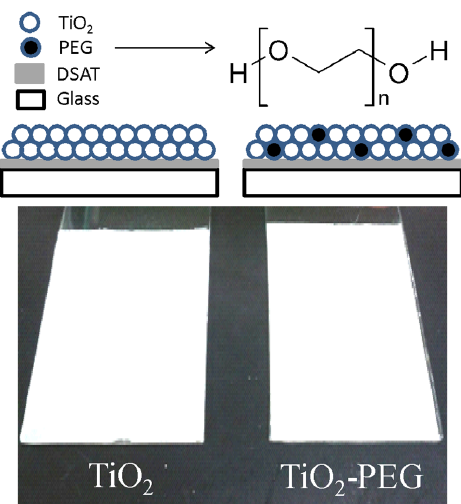
Figure 11. Picture of immobilized TiO 2 with and without PEG binder and the molecular structure of PEG.